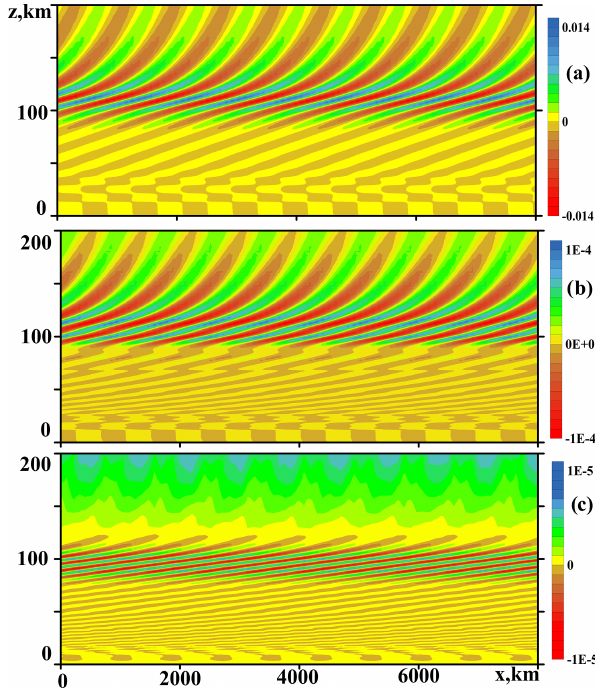
Figure 7. Same as Fig. 6, but for time moments after the wave source steep deactivating: t ≈ 140h (a) , t ≈ 200h (b) and t ≈ 250h (c)